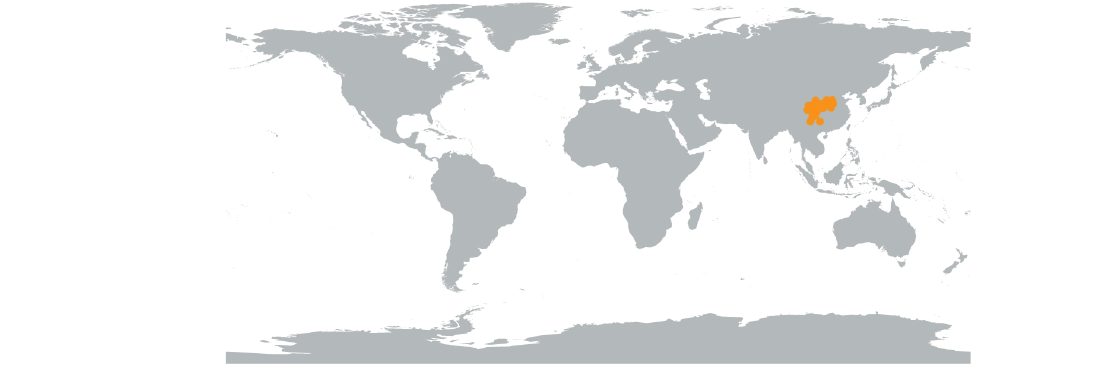
Fig. 37. Distribution of Malus honanensis